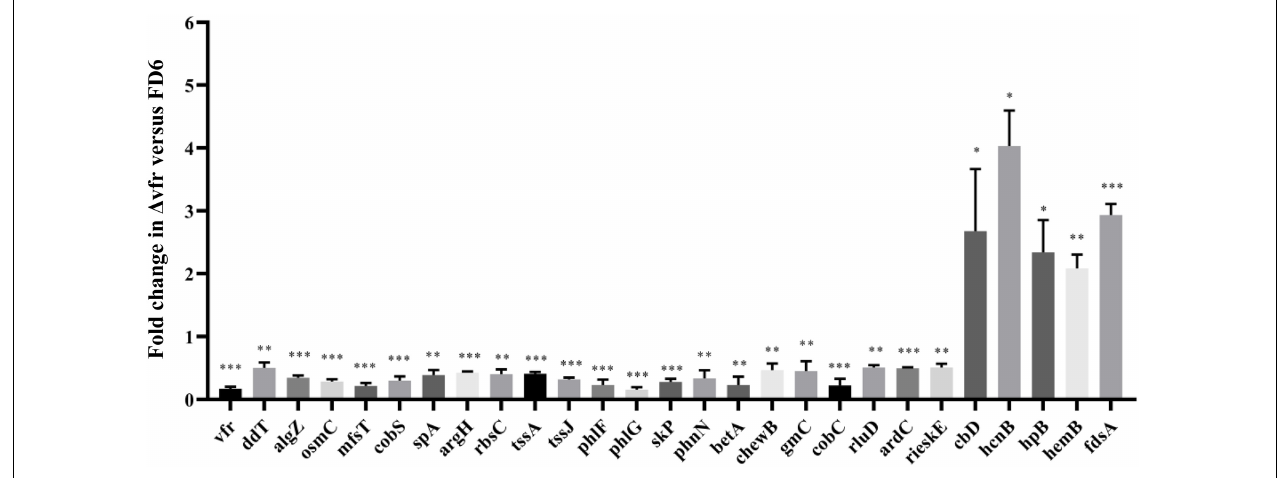
FIGURE 3 | qPCR analysis of Vfr-dependent genes. RNA was isolated from wild-type and (cid:49) vfr cells, reverse-transcribed to cDNA and assayed by qPCR with gene-specific primers as described in the text. The experiments were performed in triplicate; average values ± standard deviations are shown ∗ P < 0.05, ∗∗ P < 0.01, and ∗∗∗ P <